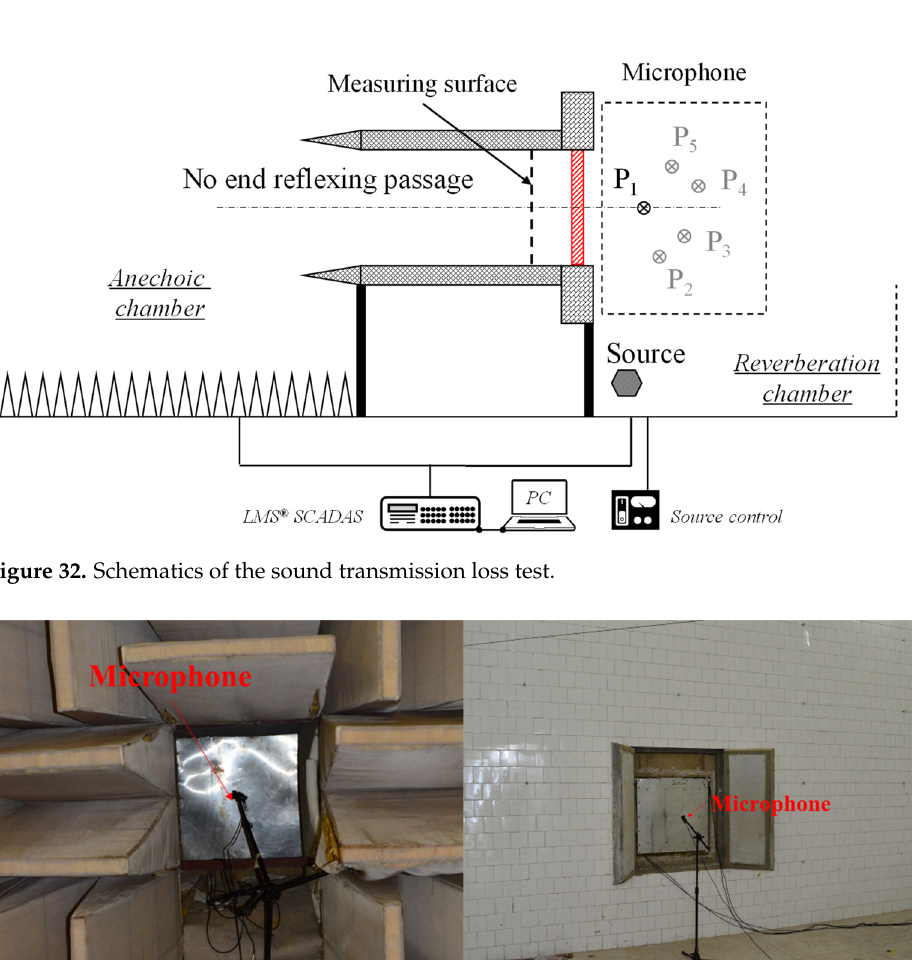
Figure 33. The photo of test-site in a single measuring.